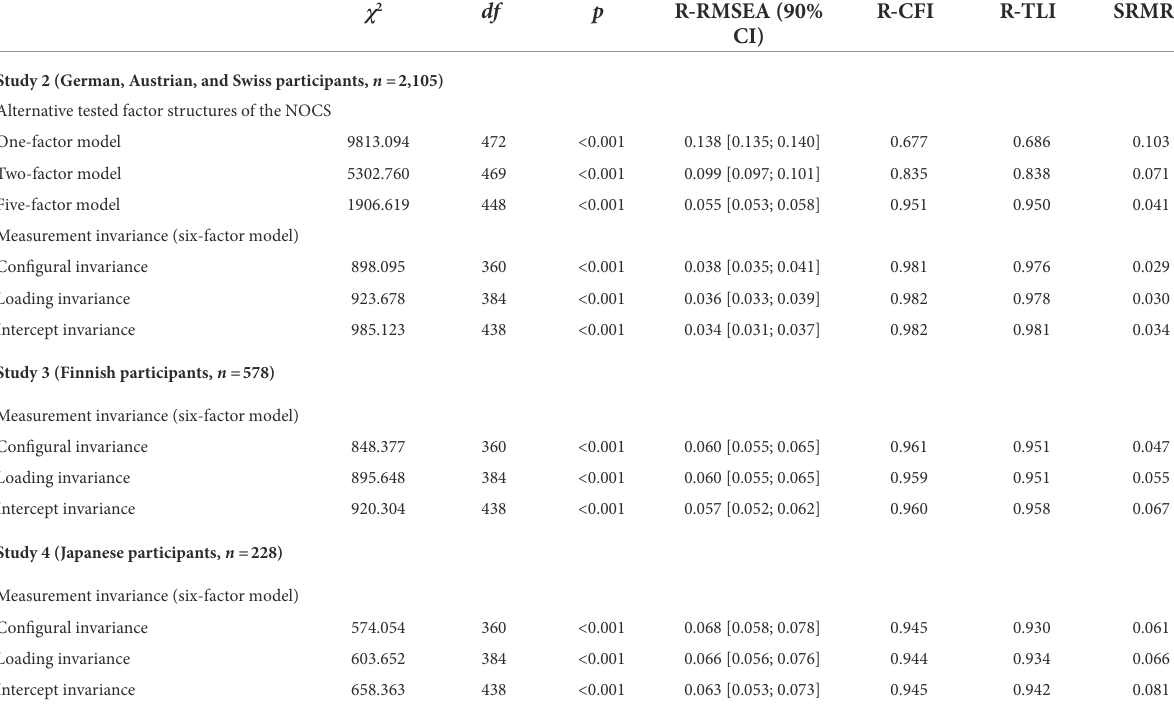
TABLE 2 Alternative models tested (Study 2) and measurement invariance over time (Studies